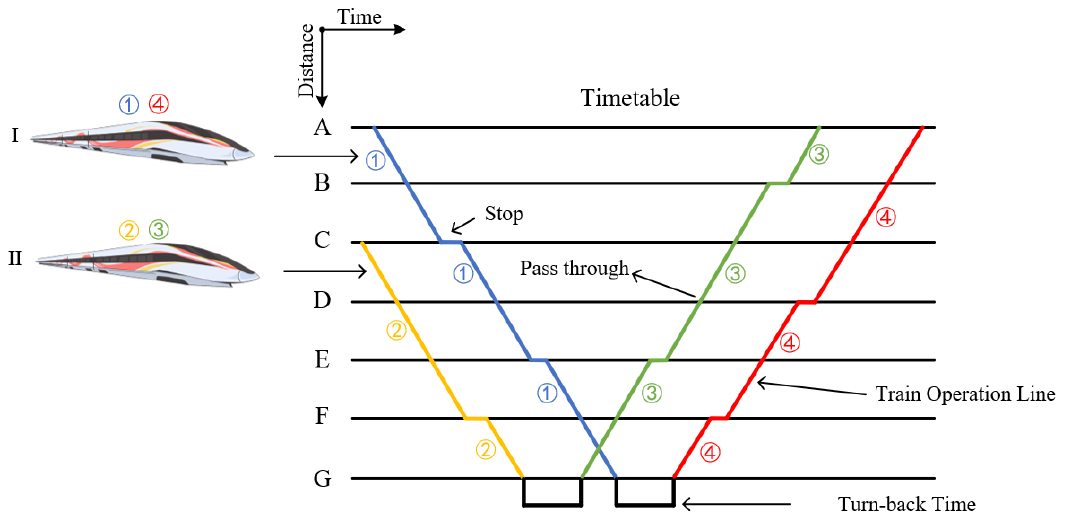
Figure 1. The schematic diagram of train-set circulation plan.